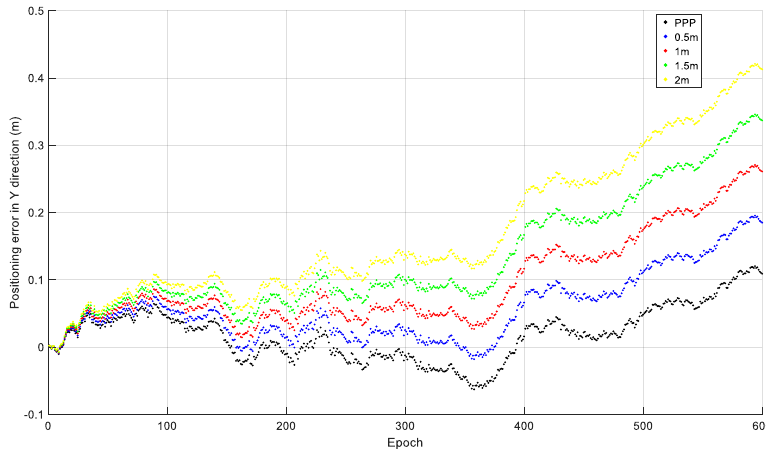
Figure 4. Positioning error in the Y direction with different initial coordinates.